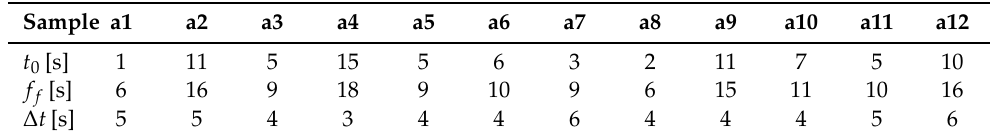
Table 2. Duration of transient time per sample ( a i